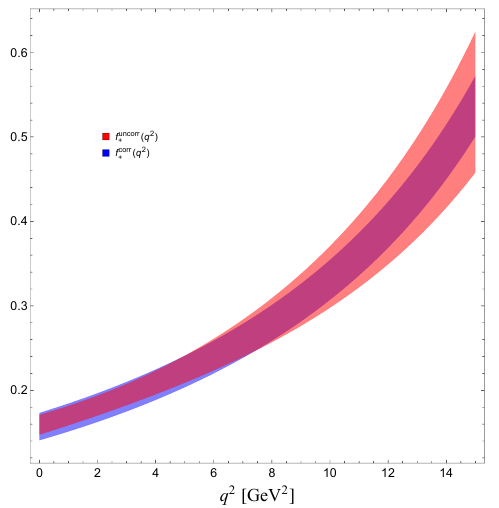
Figure 5 . Comparison of the uncorrelated (cid:12)t with the correlated